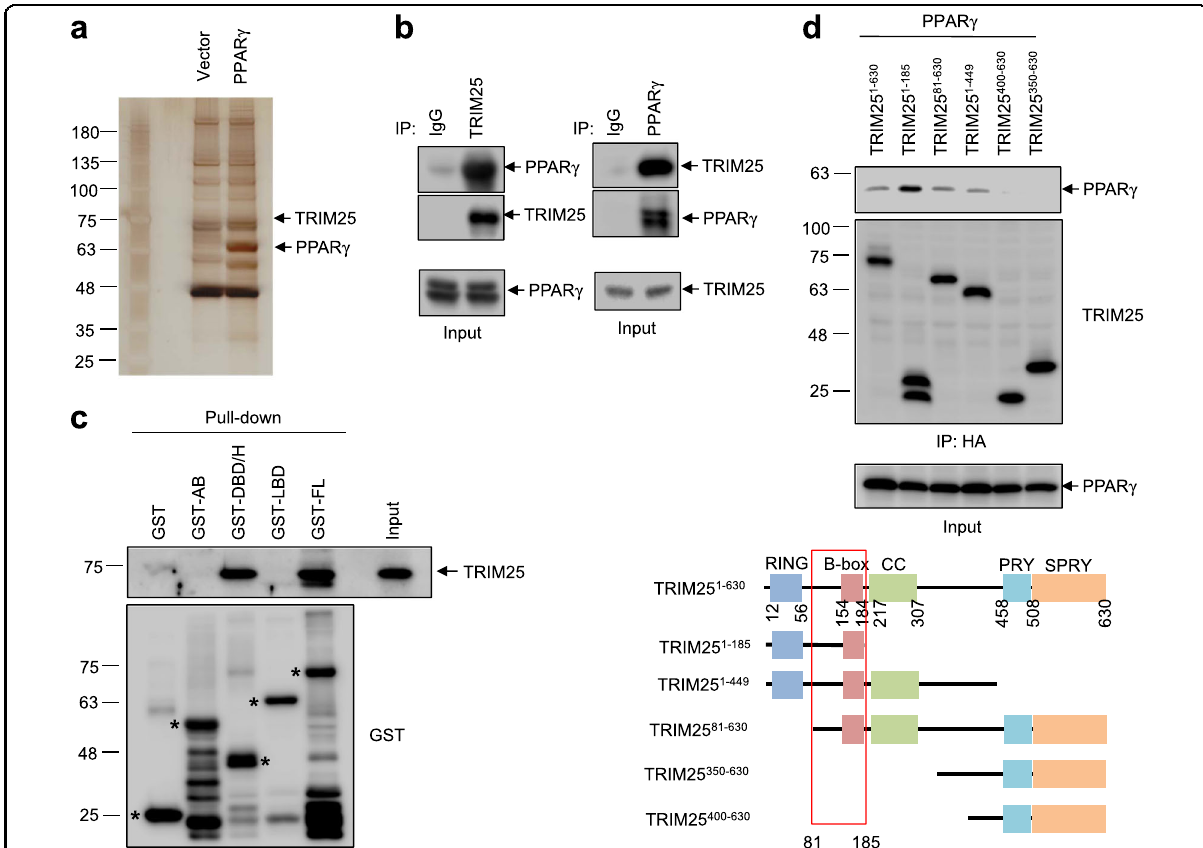
Fig. 1 TRIM25 interacts with PPAR γ . a Silver staining of PPAR γ and its associated proteins. FLAG-tagged PPAR γ was puri fi ed using FLAG M2 agarose. b The PPAR γ complexes were immunopuri fi ed from adipocytes, and endogenous TRIM25 was detected by western blotting. c GST-fused fragments of PPAR γ (A/B, LBD, DBD/H, and FL) were incubated with cell lysates containing TRIM25. The GST-fragment complexes were analyzed by western blotting. d HA-tagged deletion mutants of TRIM25 were generated and expressed with PPAR γ in HEK-293 cells. From the HA-TRIM25 complexes, PPAR γ was analyzed by western